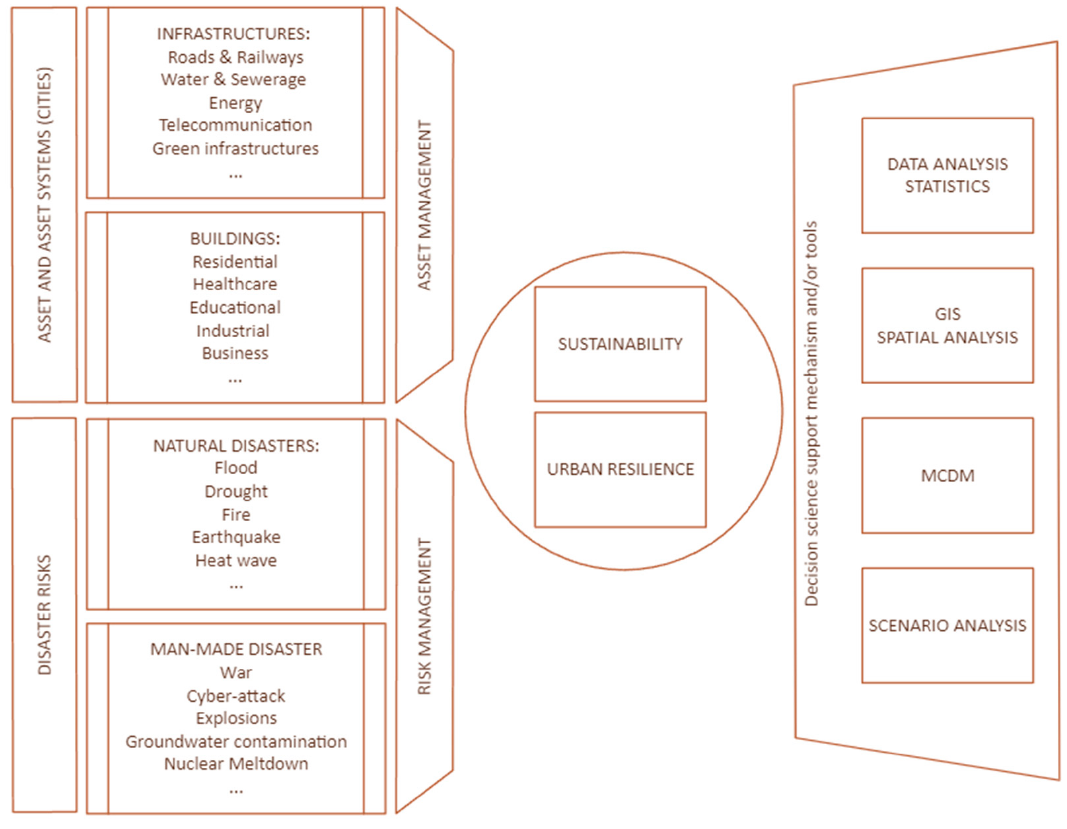
Figure 1. Background knowledge for improved multidisciplinary decisions towards sustainability and urban resilience.